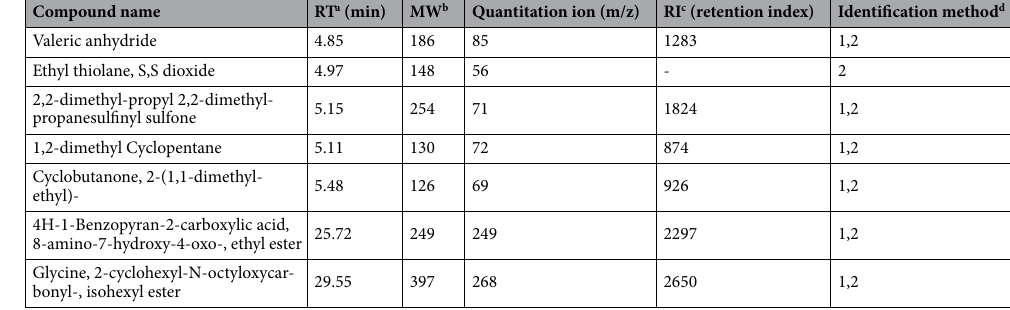
Table 2. Some of the properties of identified compounds in nettle venom based on GC–MS analysis. a Retention time. b Molecular weight. c Calculated Retention indices based on C